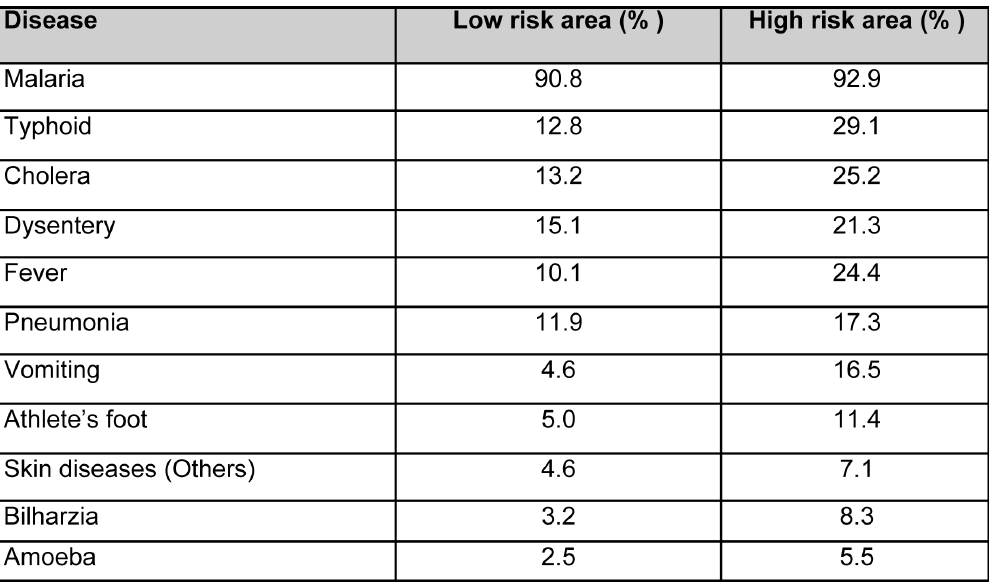
Table 2: Summary of diseases suffered by respondents during the flood